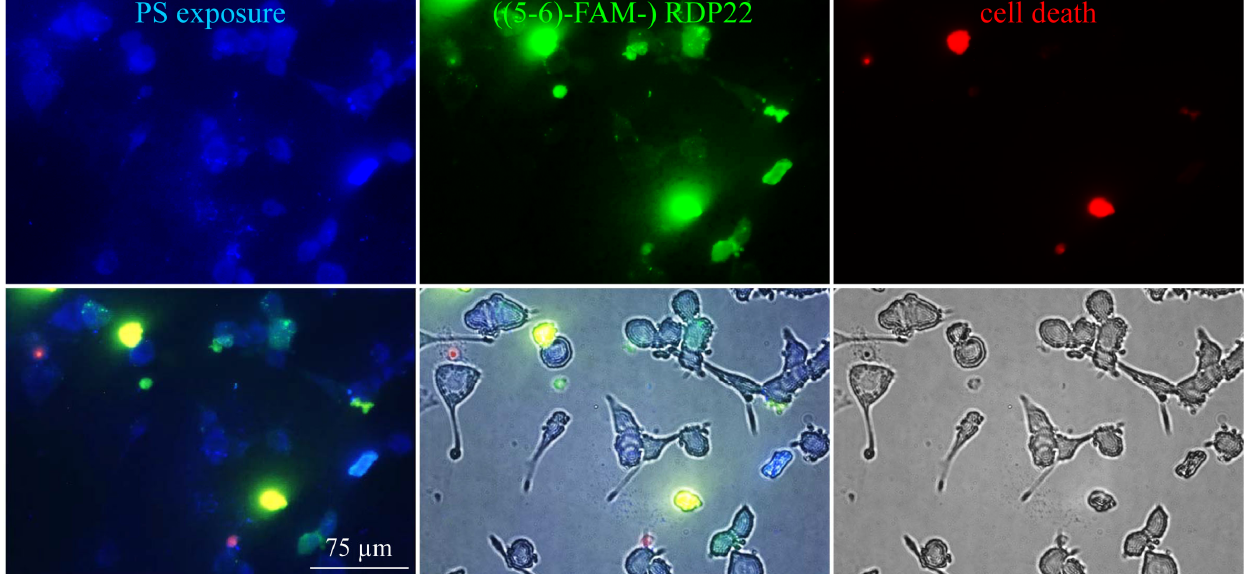
Figure 5. For investigation of potential PS ‐ peptide interaction, incubation with 10 μ M fluorescently labeled ((5 ‐ 6) ‐ FAM ‐ ) RDP22 (green) for 6 h was performed prior to PS ‐ staining of MUG ‐ Mel2 with Annexin V Alexa Fluor 350 conjugate (blue) and PI (red). In the second ‐ row overlaps of fluorescence channels, respectively including bright field or solely bright field pictures are shown. The pictures represent outcome of 3 independent experiments. RDP22 shows interaction with PS of MUG ‐ Mel2, as well as the whole cell area inside of dead cells.